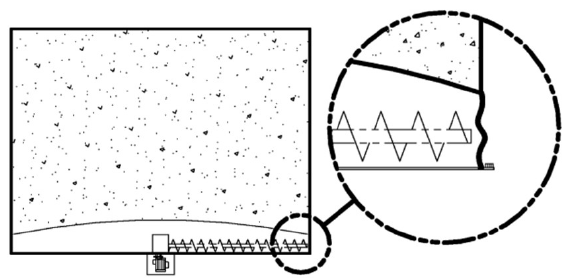
Figure 8. Potential failure mode due to buckling of unsupported wall in case of arching phenomenon. Source: [116].